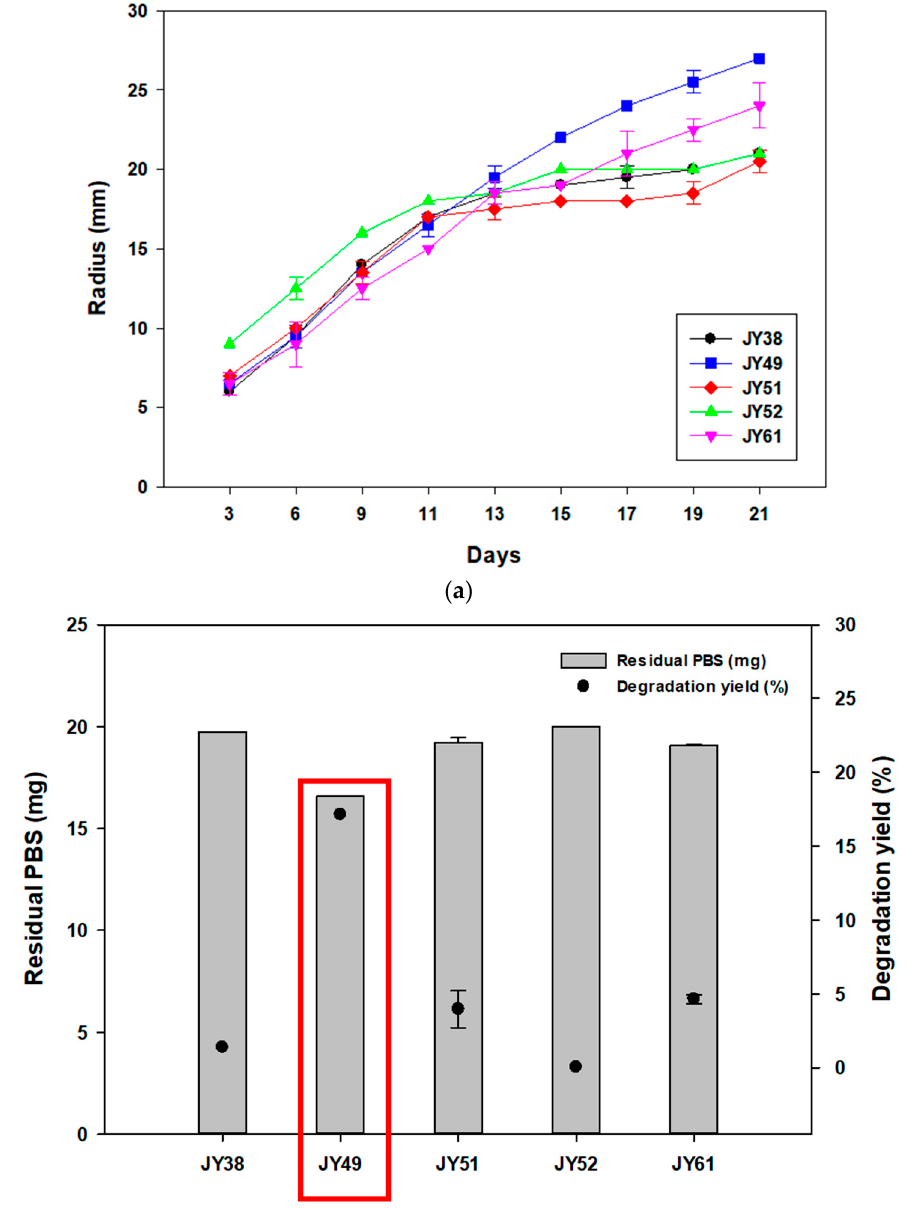
Figure 1. Comparing PBS-degrading strains using solid and liquid cultures and identifying the selected strains. ( a ) The changes in radius size of clear zones for 21 days at 30 °C. ( b ) Amount of residual PBS and degradation yield of five PBS-degrading strains using GC-MS analysis.